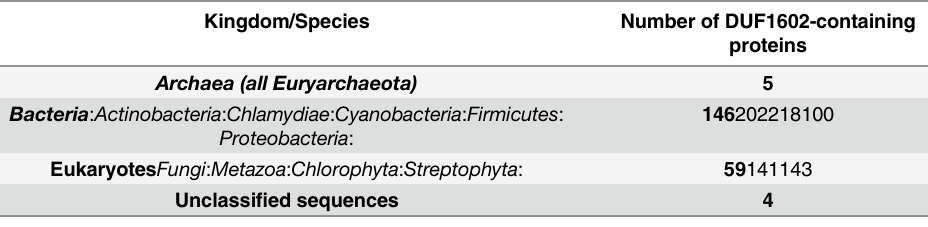
Table 3. Phylogentic distribution of DUF1602-containing